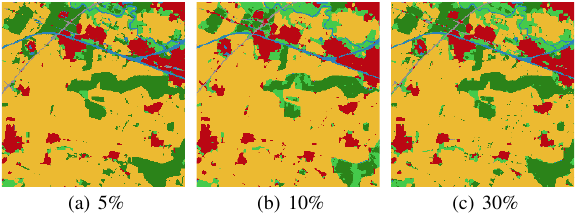
Figure 6. Exemplary prediction results for the tile in R 1 for three different levels of label noise. Colour code: cf. figure